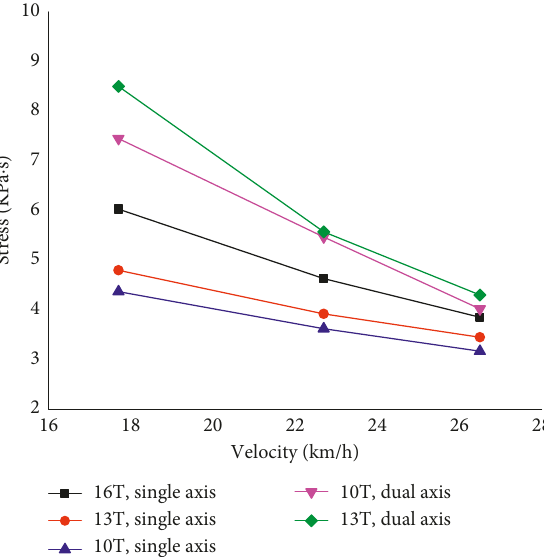
Figure 17: Time accumulation of